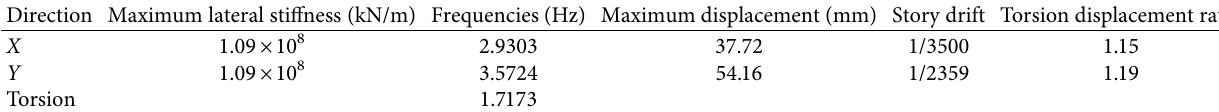
Figure 1: Sketch of prototype building: (a) elevation view; (b) floor plan below the 41 st story (units: mm). Table 1: Dynamic characteristics and seismic response of the prototype